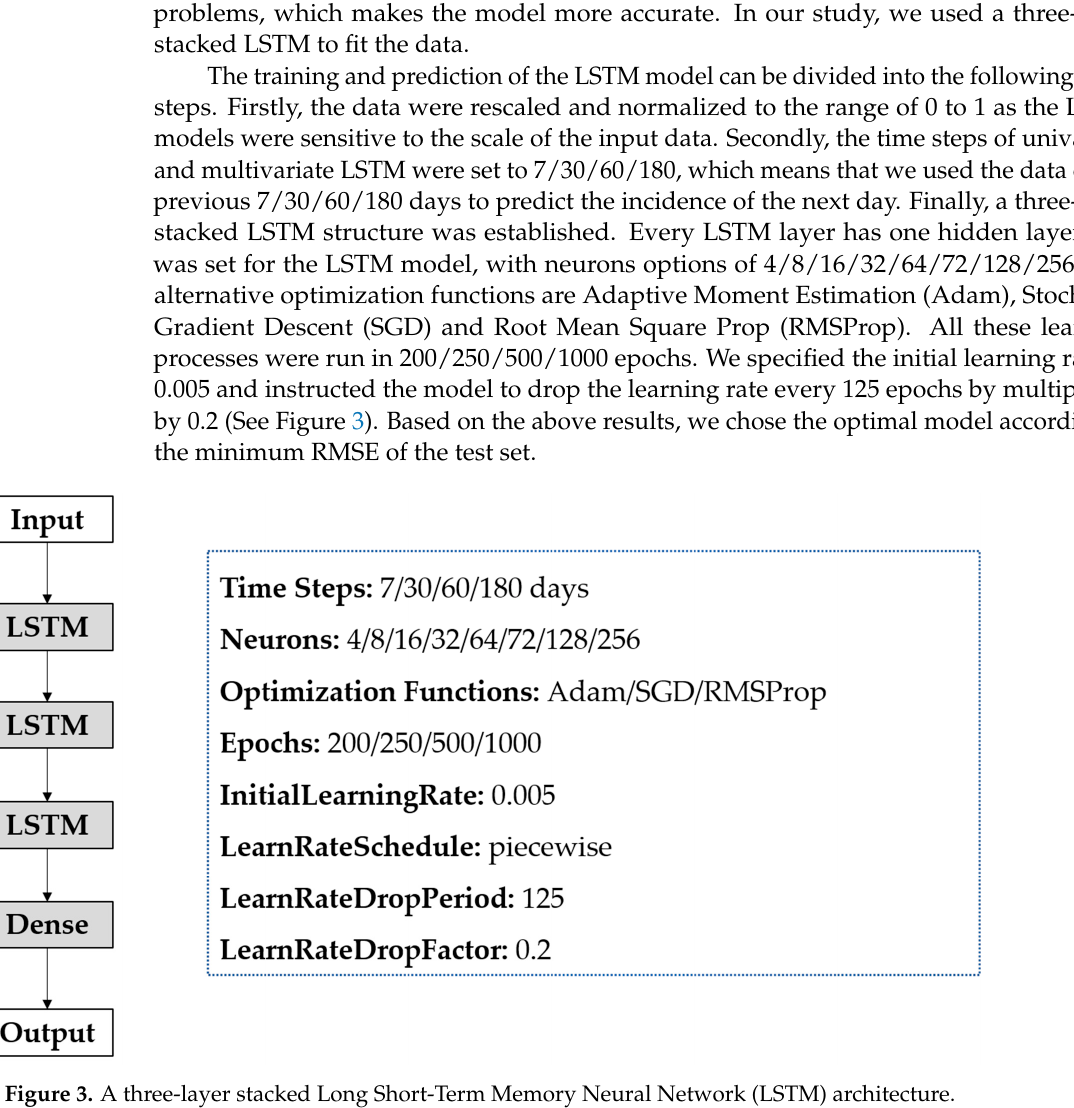
Figure 3. A three-layer stacked Long Short-Term Memory Neural Network (LSTM)